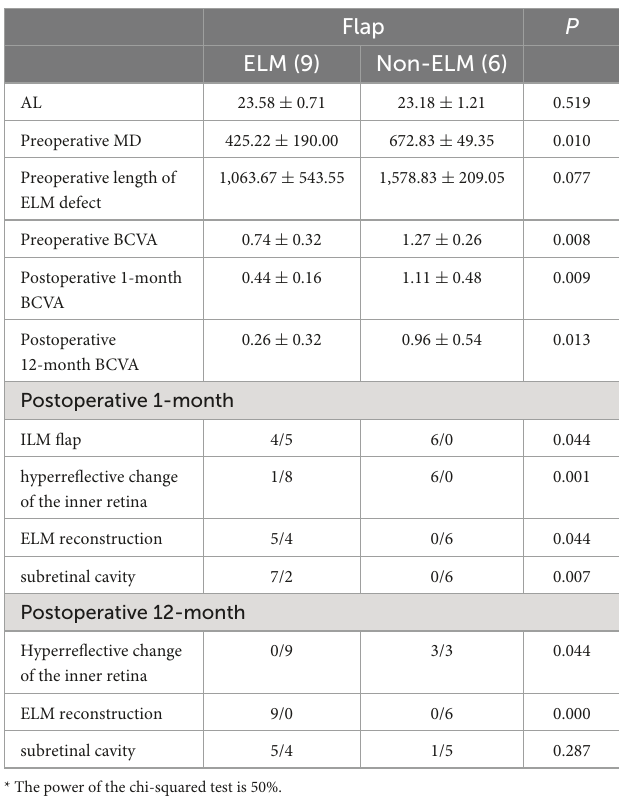
TABLE 3 Comparison of the preoperative and postoperative anatomical structures and visual function of the flap and peeling groups for MDs of > 579 µ m*.